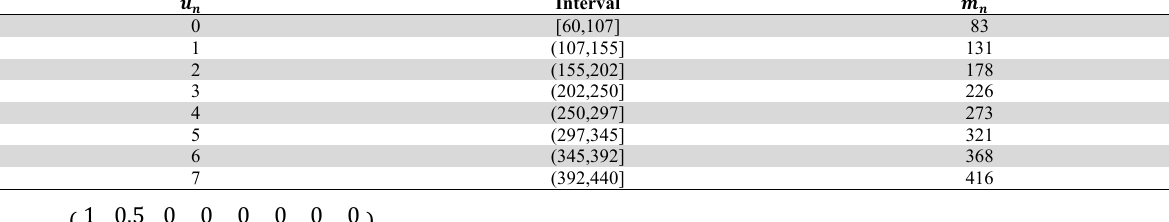
The fuzzy set interval and middle value of